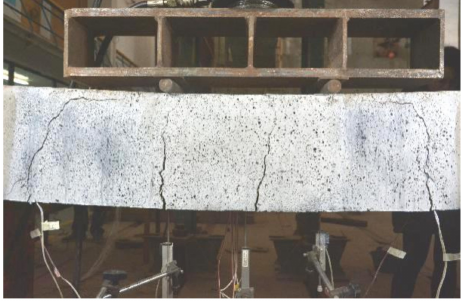
Figure 8. Failure of SSC